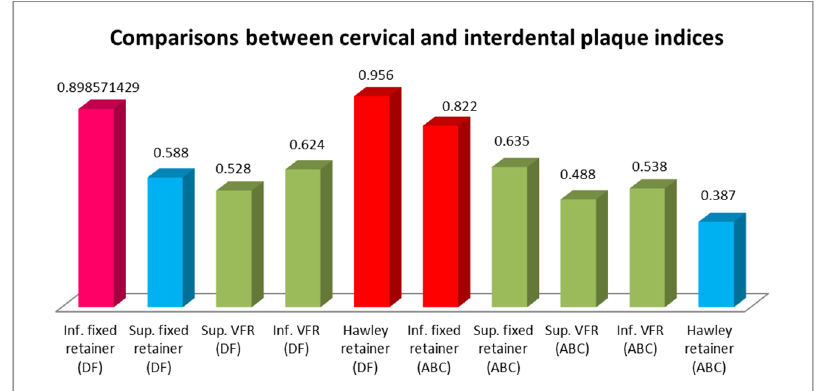
Figure 9. Navy plaque index modified by Rustogi, female study group. DF = interproximal areas ABC = gumline areas.